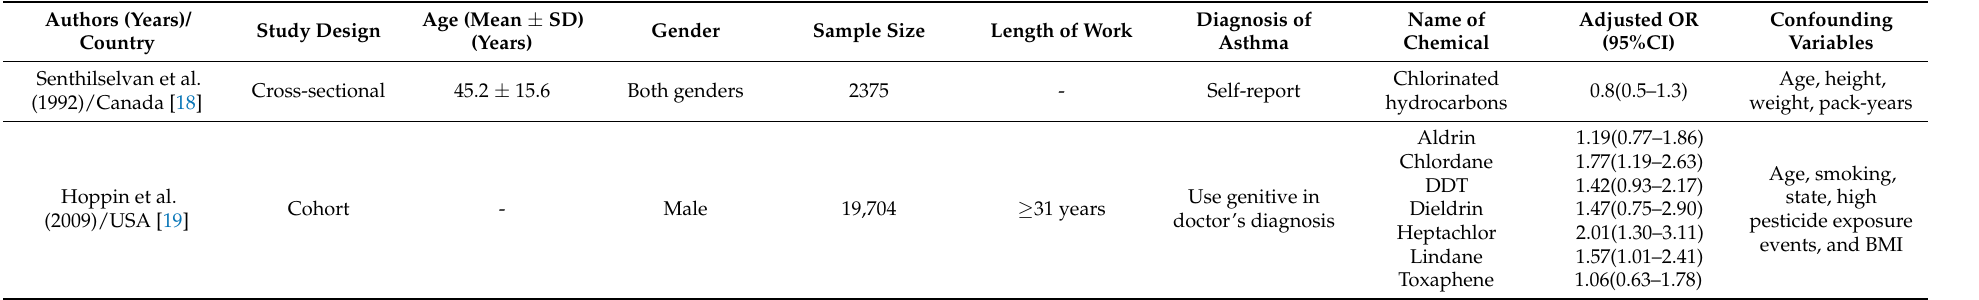
Table 3. The characteristics of studies evaluating the association between exposure to organochlorines and asthmatic